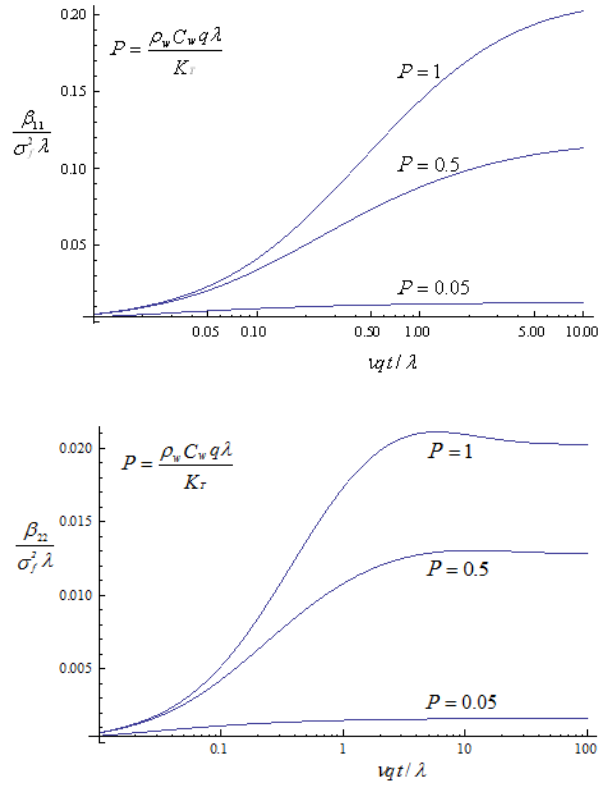
Fig. 1. Normalized (a) longitudinal and (b) transverse macrodispersivities as a function of normalized travel time.